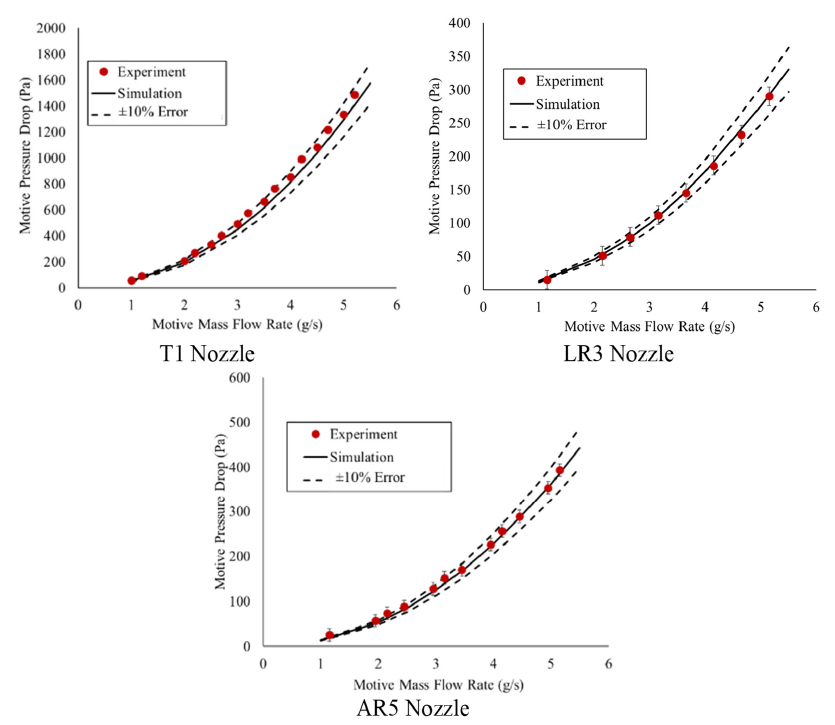
Figure 4. Mesh refinement study. Once the number of elements was increased past 828,360, there was effectively no change in the result and mesh independence was reached.